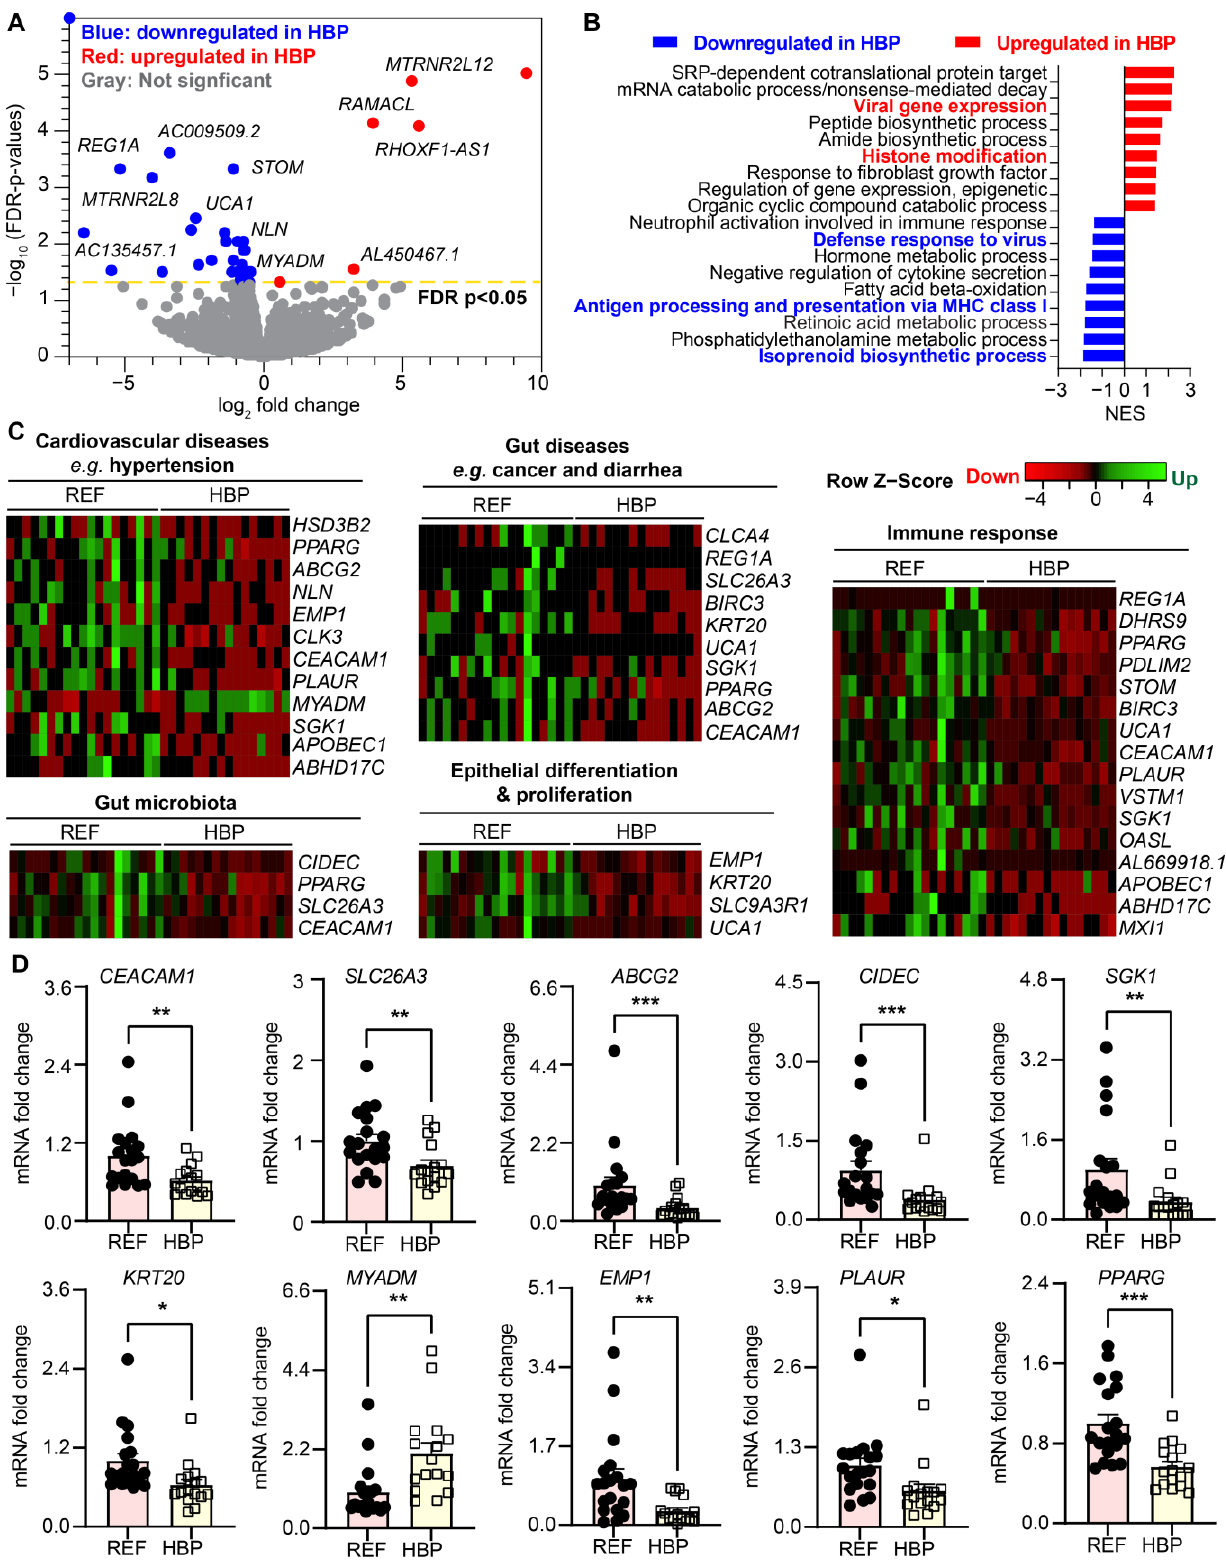
Figure 2. Comparison of the transcriptomes of colons of REF and HBP subjects. ( A ) Volcano plot showing differentially expressed genes (DEGs) in colonic epithelium from REF (n = 19) with HBP (n = 16) subjects. FDR-corrected p < 0.05, blue circles, downregulated DEGs; red circles, upregulated DEGs in HBP subjects; gray circles, genes with no difference in expression. ( B ) Pathways signifi- cantly enriched in colon of HBP subjects compared with control subjects (FDR-corrected p < 0.05).